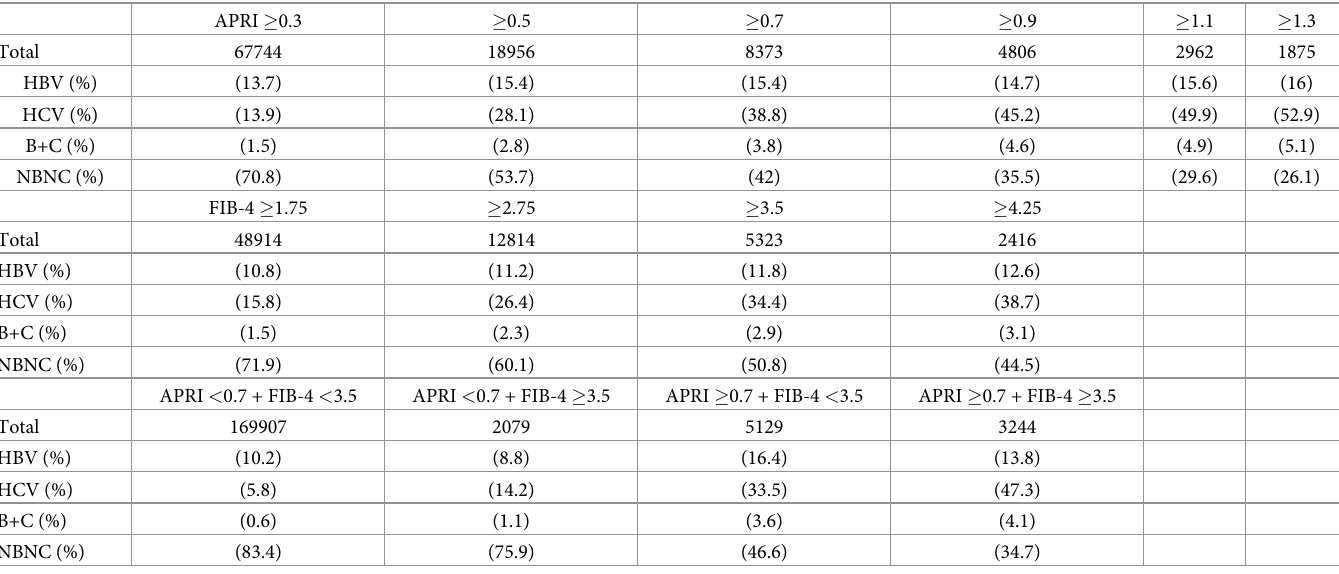
Table 2. Distibutions of virus hepatitis in enrolled participants based on different cut-offs of APRI and FIB-4. APRI �